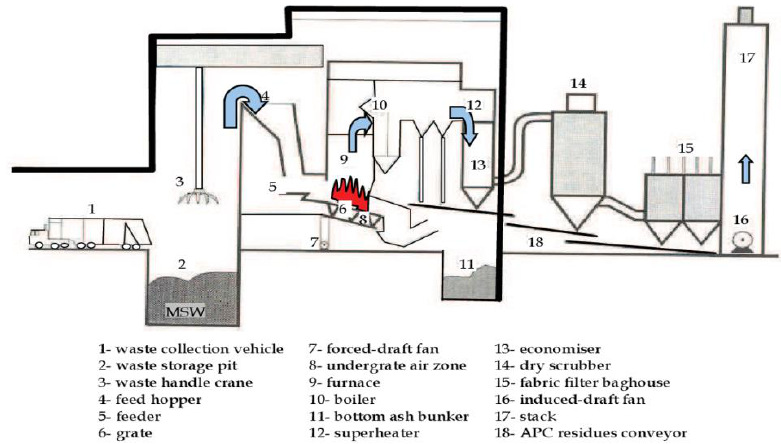
Figure 3. Incinerator designed for degrading municipal solid wastes (MSW) containing pesticides. Reproduced from [49]. (creative commons).